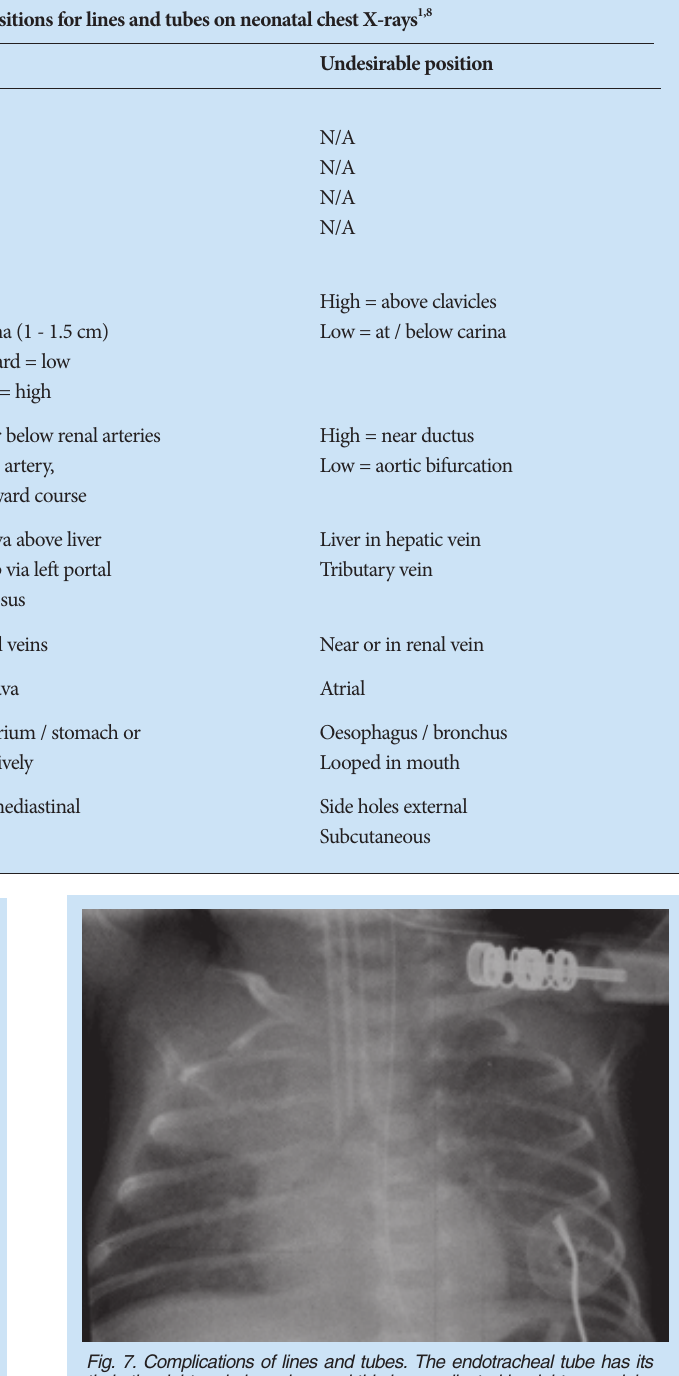
Fig. 7. Complications of lines and tubes. The endotracheal tube has its tip in the right main bronchus and this is complicated by right upper-lobe